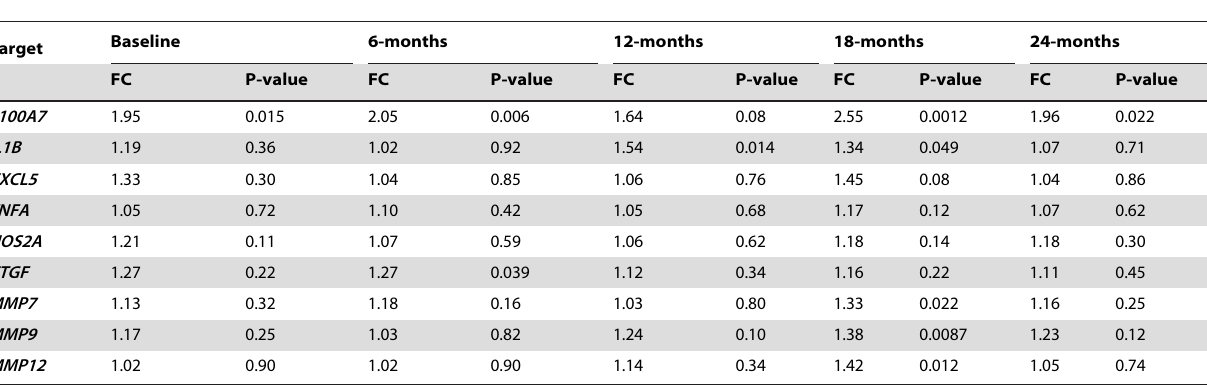
Table 3. Gene expression level in recurrent TT cases relative to non-recurrent controls.